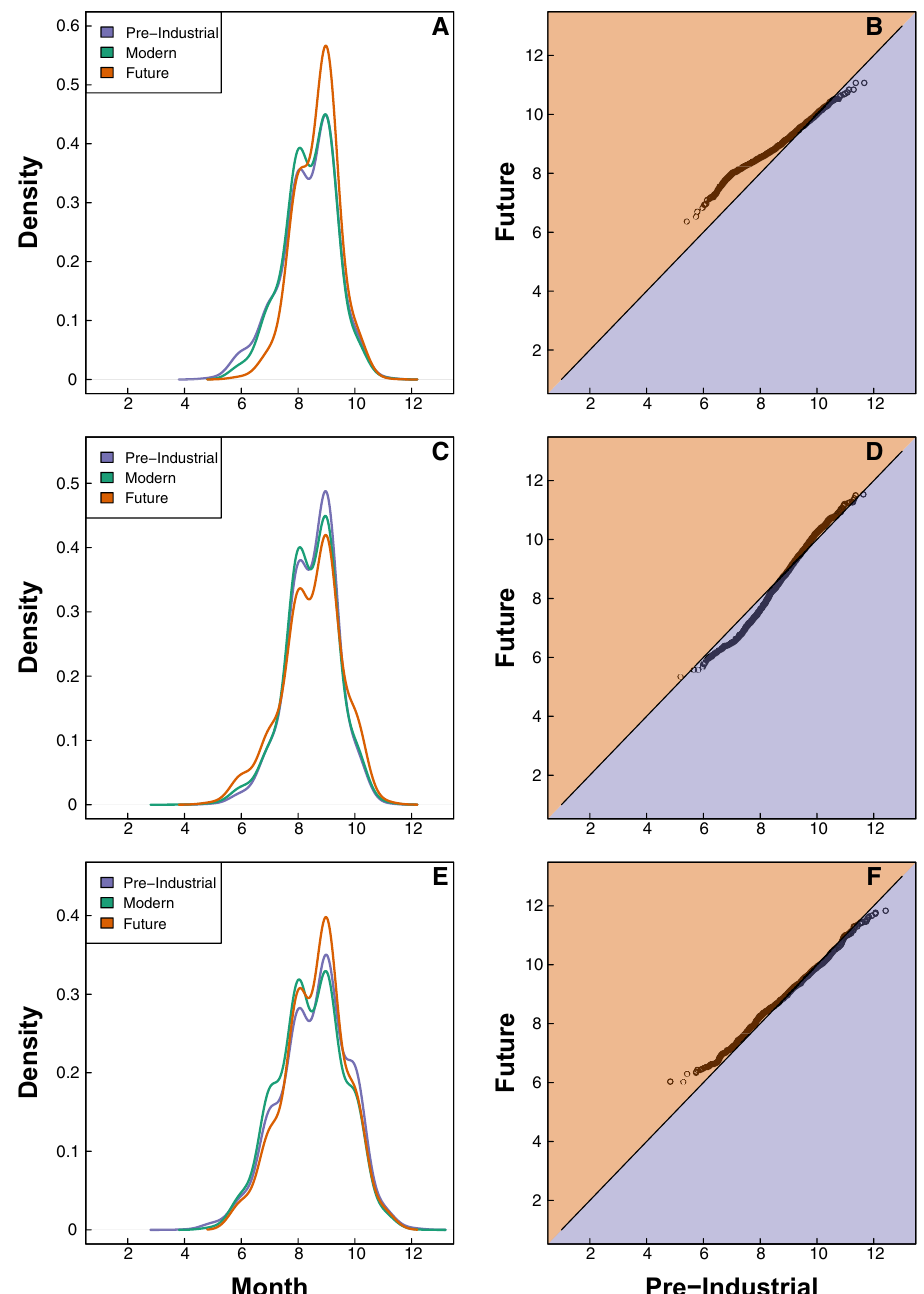
Figure 6. Probability density functions ( A , C , E ) and QQ-plots ( B , D , F ) of TC genesis points within each region. PDFs of ( A ) MDR genesis, ( C ) SE US genesis, and ( E ) Caribbean genesis are shown for the pre-industrial (purple), modern (green), and future (orange) eras. QQ-plots show the quantile differences of pre-industrial (purple background) and future (orange background) distributions for ( B ) the MDR, ( D ) the SE US, and ( F ) the Caribbean. Black solid lines on the QQ-plots show the 1–1 line; points that diverge from this line indicate that the pre-industrial and future distributions are significantly